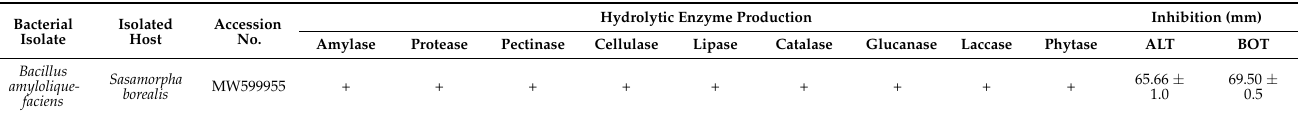
Figure 2. Maximum likelihood tree based on RPB2 nucleotide sequences for the selected isolates of species in the genus Botrytis . Bootstrap values (>50) are represented by numbers at the nodes based on 1000 replications. The strain in red font is from our study. Table 2. Hydrolytic enzyme activity of bacterial strain and its effect on the inhibition of Botrytis pelargonii and Alternaria alternata